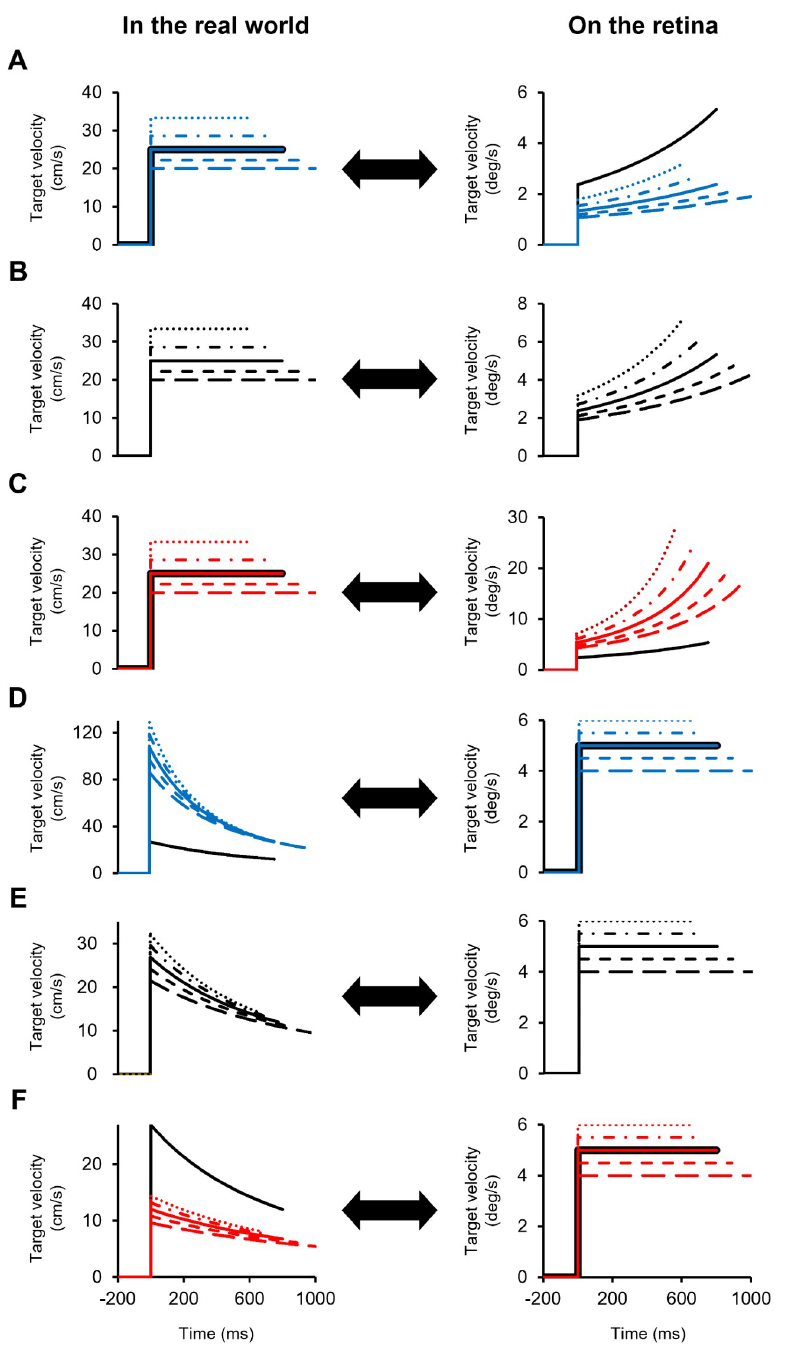
Fig 3. Target velocity of a speed perception task in the real world and on the retina. In the world constant task, the far (A), middle (B) and near (C) conditions are shown, and the target moves at a constant speed in the real world (physically), but it moves with acceleration on the retina. In the retinal constant task, the far (D), middle (E). and near (F) conditions are shown, and the target moves at a constant speed on the retina, but it moves with deceleration in the real world. The dotted, dashed-dotted, solid, short dashed and long dashed lines represent the order of speed. The blue, black and red lines indicate the far, middle and near conditions, respectively. The black solid lines indicate standard